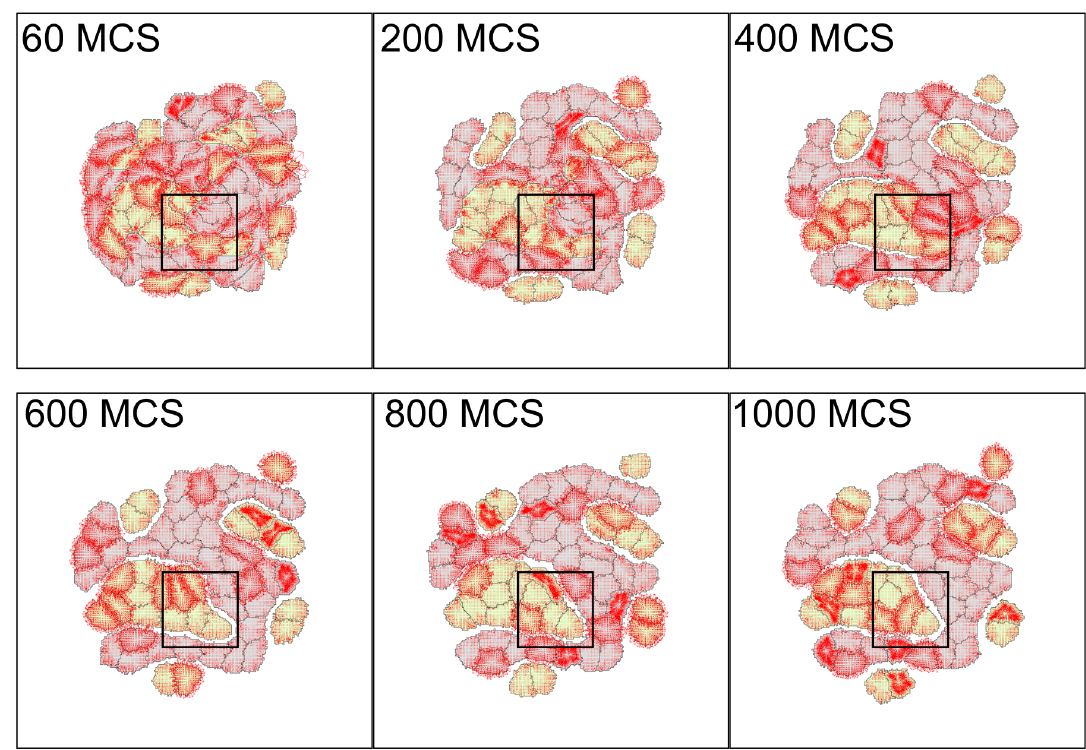
Fig 9. Separation cell sorting simulation with force visualization. Parameter values were a = 300, λ a = 1000, p = 67, λ p = 20, J (0, grey) = 1800, J (0, green) = 1800, J (grey, grey) = 900, J (green, green) = 900, J (grey, green) = 9000, ξ ( r ) = 18, and r = 3 for all neighborhood calculations. The cellular temperature T was set to 600. Zooms of the cells and forces inside the black squares can be viewed in S18 Fig. See also S19–S23 Figs.